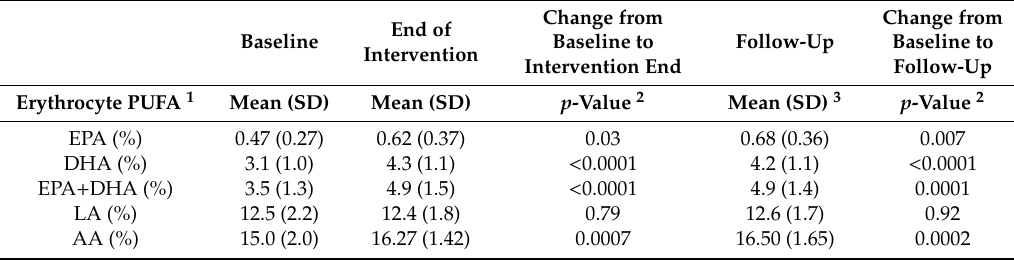
Change from Change from End of Baseline to Follow-Up Baseline to Baseline Intervention Intervention End Follow-Up